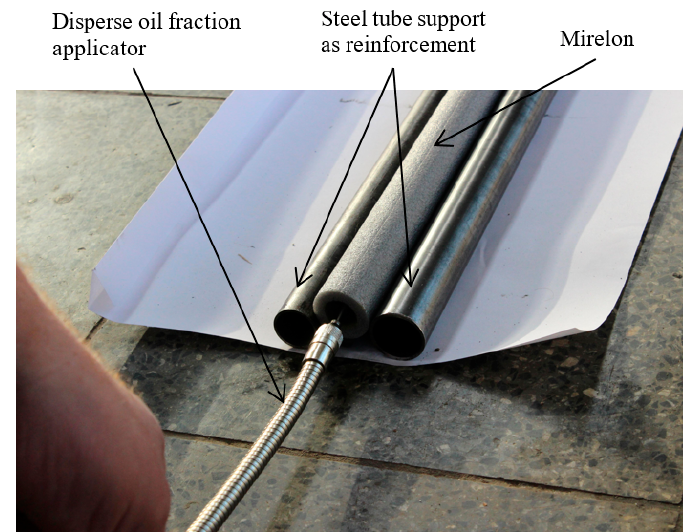
Figure 15. Implementation of experimental measurement with the SMC LMV210-35 Mixing Valve, which produced a consistent dispersion oil fraction.